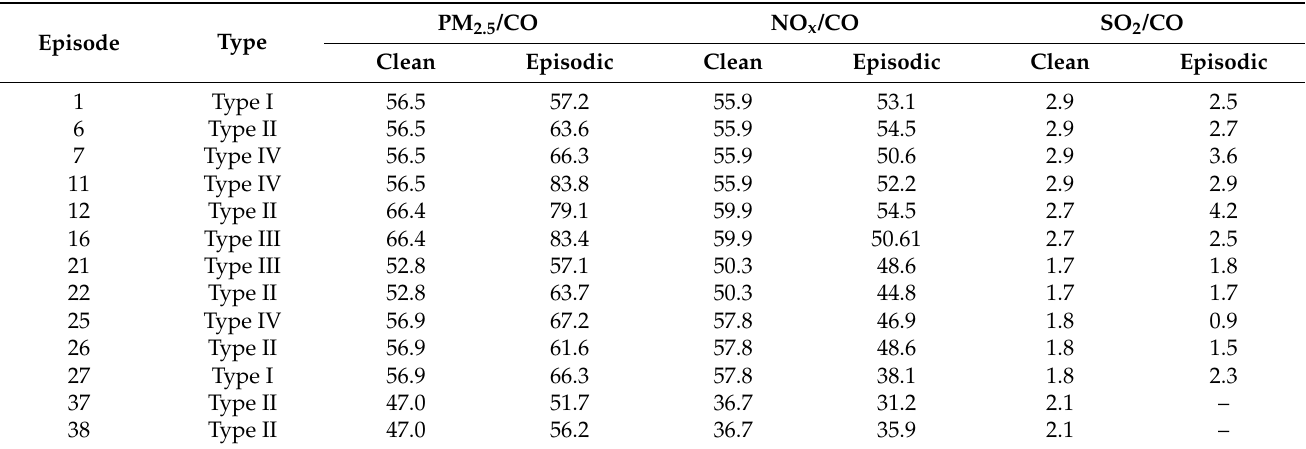
Table 4. Average PM 2.5 /CO, NO x /CO, and SO 2 /CO during the haze episodes potentially affected by secondary aerosols.